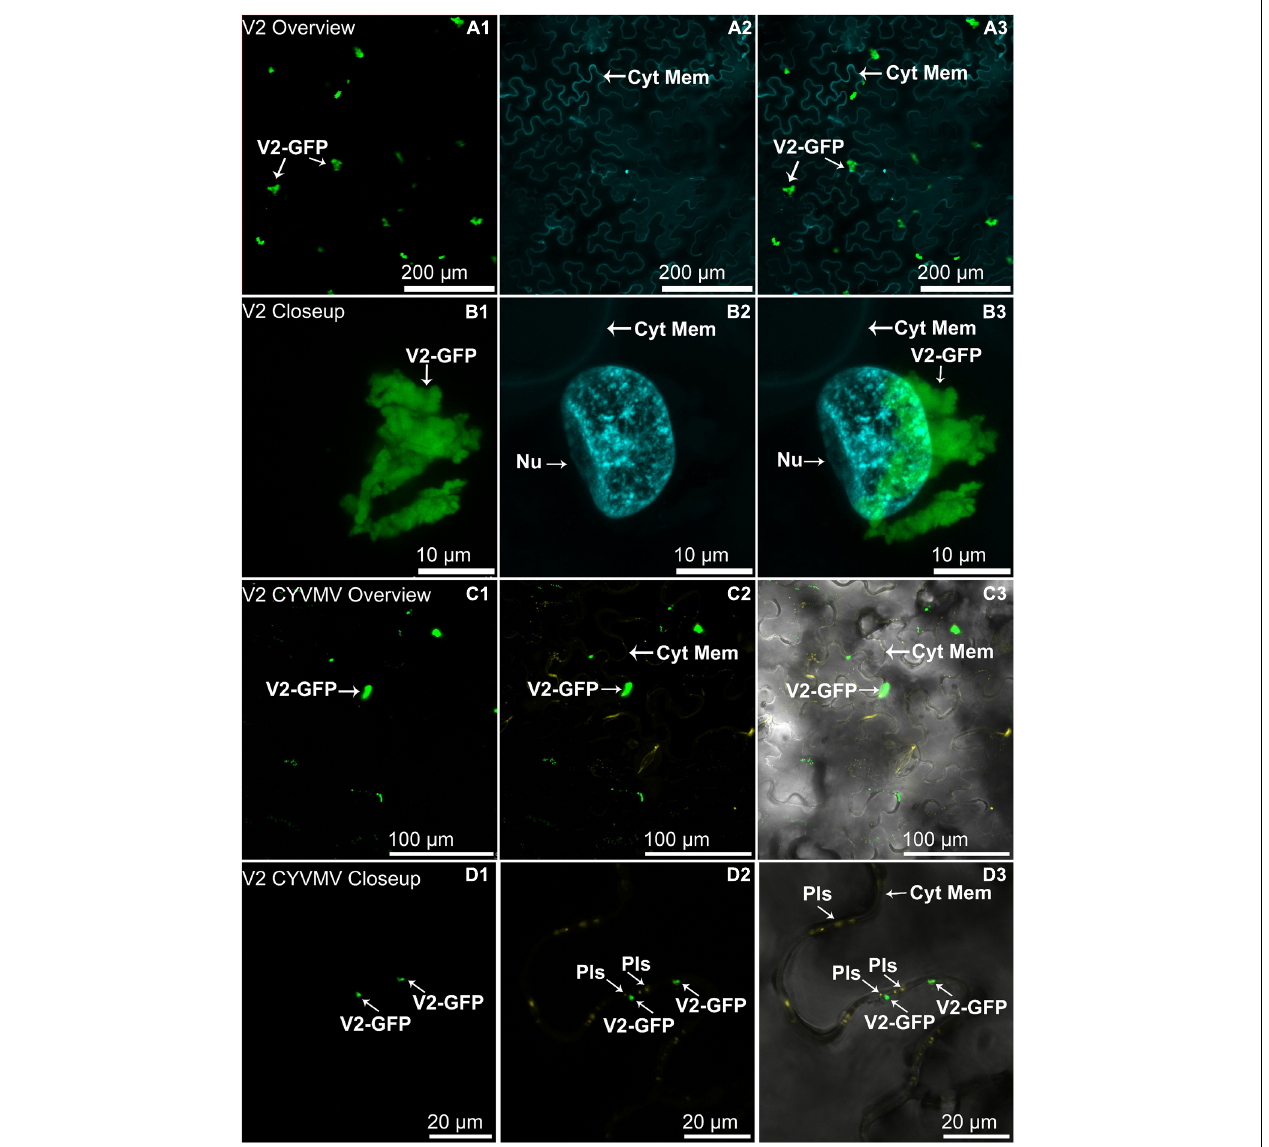
FIGURE 3 | Subcellular localizations of enhanced green fluorescent protein (eGFP)-tagged V2 of CYVMV (CYVMV, V2-GFP) in N. benthamiana leaves under stand-alone (A,B) and CYVMV-inoculated (C,D) conditions. Panels (A,C) were taken under lower zoom, while panels (B,D) were taken with higher zoom. Images showing GFP fluorescence (A1,B1,C1,D1) , Hoechst fluorescence (A2,B2) and aniline blue bound to the plasmodesmata (C2,D2) . Merged images of both GFP and Hoechst fluorescence were shown as panels (A3,B3) . Merged GFP, aniline blue, and the bright field are shown in panels (C3,D3) . V2-GFP alone was found to aggregate as large clumps in various locations within the cytoplasm. Co-infiltration of V2-GFP and CYVMV turned some large V2-GFP clumps into smaller particles, which were loosely associated with the cell wall and moved to reach plasmodesmata. Arrowheads indicate the locations of V2-GFP and major sub-cellular organelle (Nu, nucleus; Pls, plasmodesmata; Cyt Mem, cytoplasmic membrane).